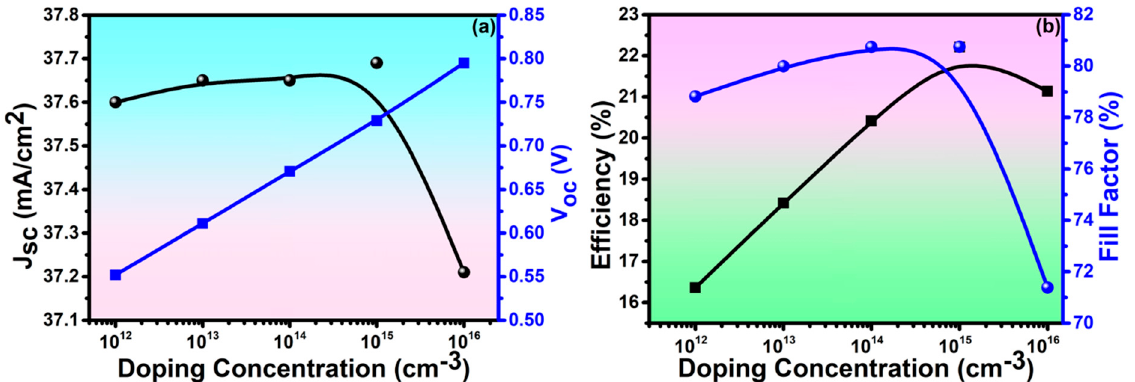
Figure 3. Impact of doping concentration on ( a ) short ‐ circuit current density and open ‐ circuit voltage, and ( b ) efficiency and fill factor for THE p ‐ type region.